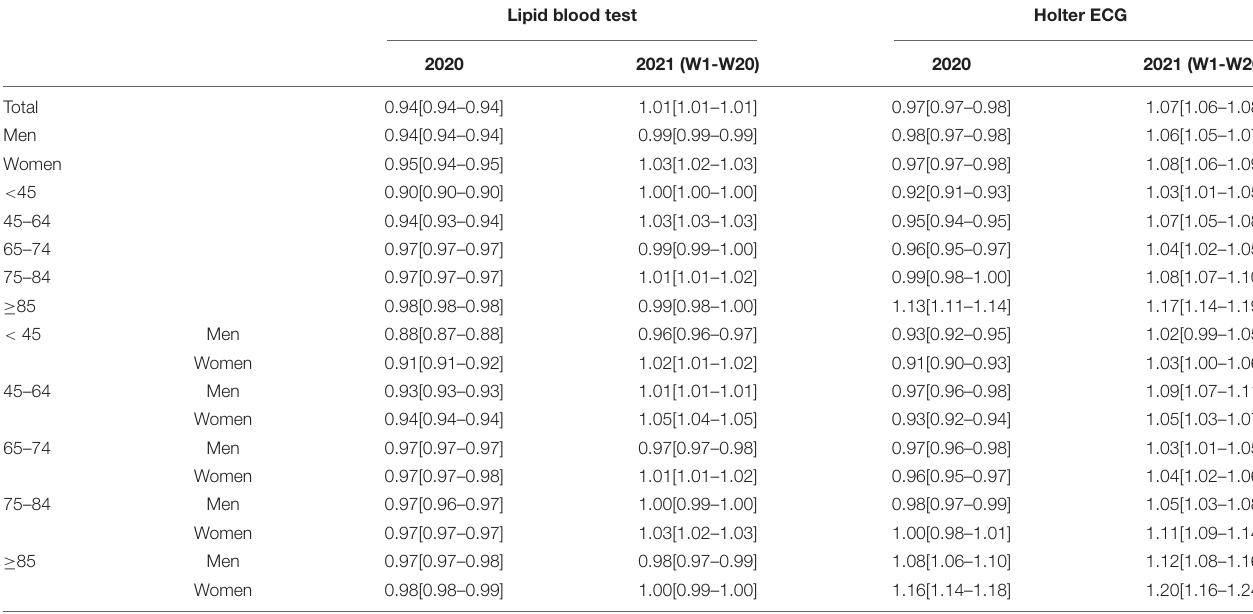
TABLE 3 | Incidence rate ratio (IRR)* and 95% confidence intervals (95% CI) for the rates of people with at least one lipid blood test and one Holter ECG in 2020 and 2021 compared to the rates in 2017–2019. Lipid blood test Holter